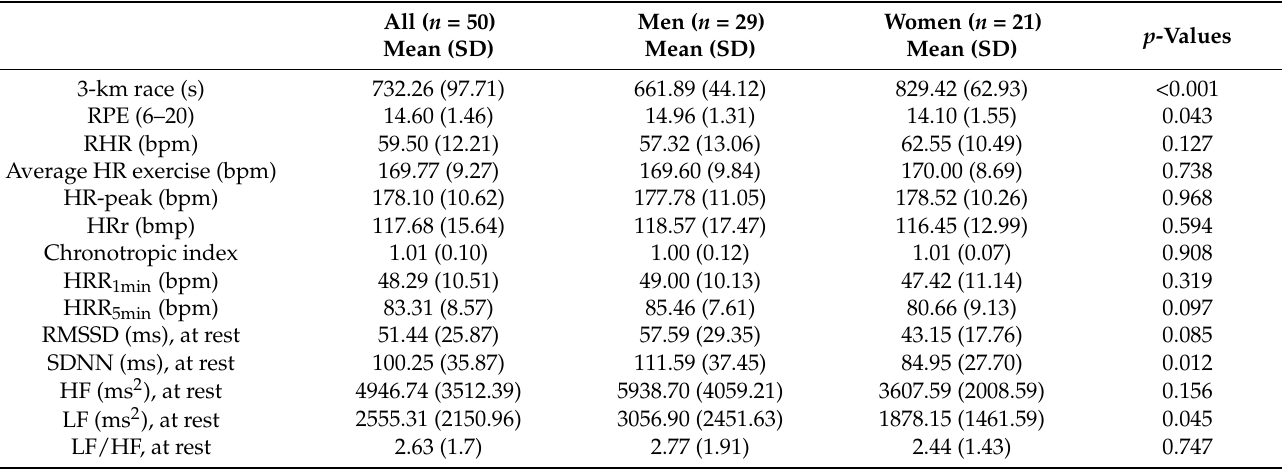
Table 2. Cardiovascular autonomic modulation at rest, during exercise and following maximal exercise in master runners well trained.